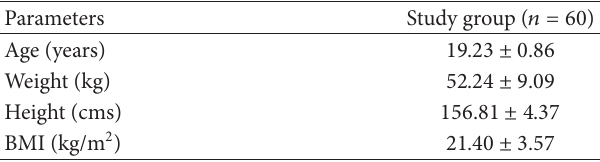
Table 2: Pairwise comparison of visual choice reaction time among